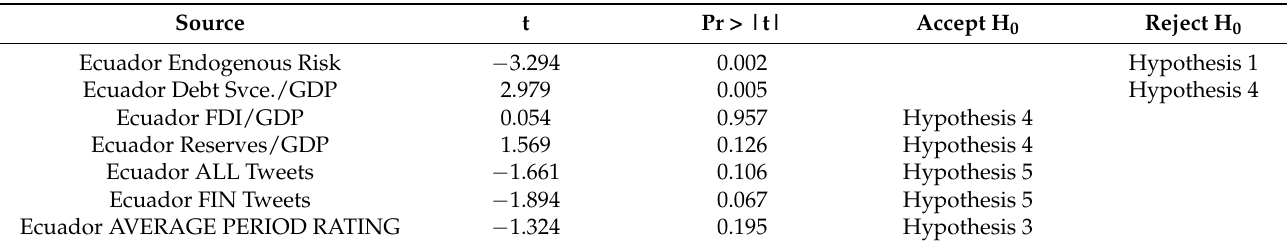
Table 9. Model parameters for Ecuador.